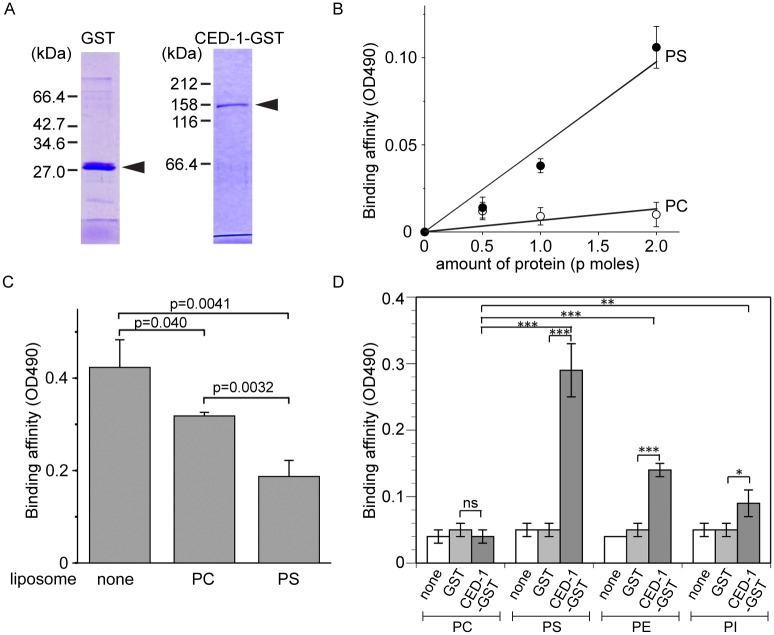
The extracellular domain of CED-1 directly associates with PS.The entire extracellular region of CED-1 fused to GST (CED-1-GST) was tested for the binding to phospholipids. Data were representative of three independent experiments that yielded similar results. (A) Detecting the purified GST or CED-1-GST using SDS-PAGE. Molecular weight markers are marked on the side. Arrowheads mark the purified proteins. (B) The binding affinities of identical amount of CED-1-GST and GST to PS and PC were measured in ELISA-like reactions. Data shown here are results after subtracting the OD value corresponding to GST from that corresponds to CED-1-GST at each data point. (C) The binding affinity of CED-1-GST (6.3 p mole in 0.1ml volume) to PS was analyzed in ELISA-like reactions in the presence of PC-only liposomes (0.5 mM) or PS-containing liposomes (0.5 mM) as competitors. (D) The binding of GST and CED-1-GST (both in 6.3 pmol in 0.1ml volume) to various phospholipids, including PC, PS, phosphatidylethanolamine (PE) and phosphatidylinositol (PI), was examined in ELISA-like reactions. *, 0.002<p<0.005; **, 0.001<p<0.002; ***, p<0.001; ns, no significant difference; Student t-test.